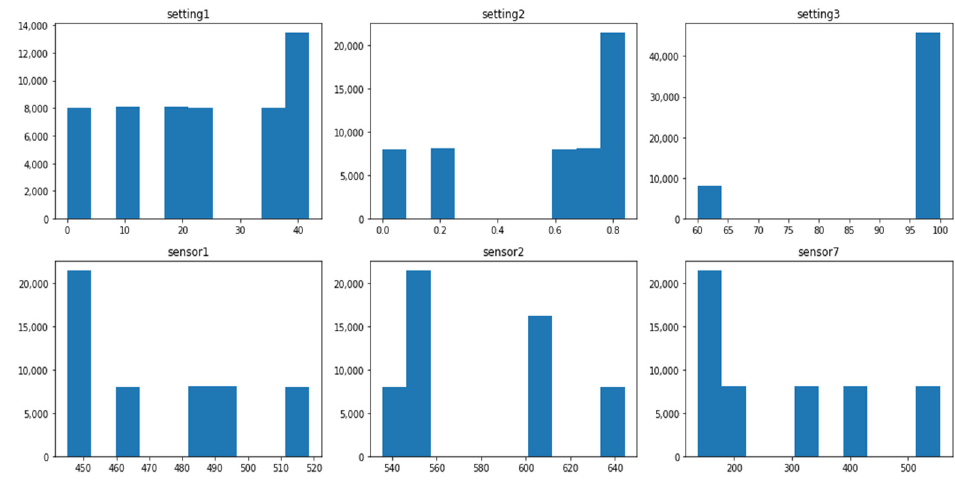
Figure 2. FD002_Train—distribution of selected variables.